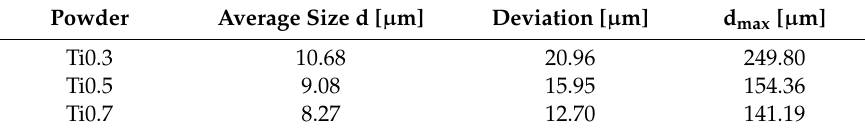
Table 2. The average sizes of the Ni1.5Co1.5CrFeTix powder particles after mechanical alloying.